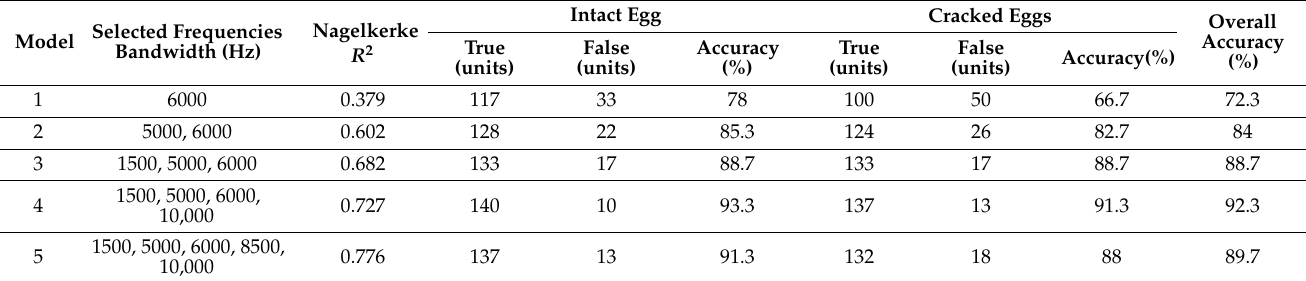
Table 2. Accuracy of four models of eggshell crack detection by the calibration set.